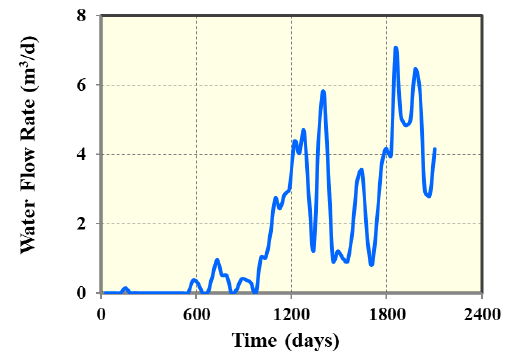
Figure 27. Actual field water intrusion behavior of well B2.